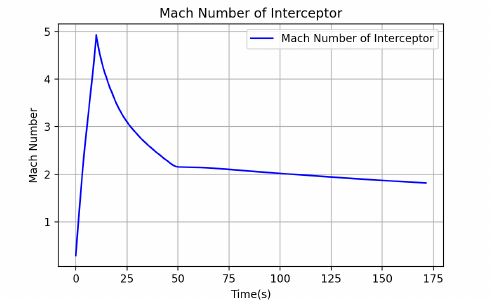
Figure 14. Line-of-sight angle (target maneuvering).